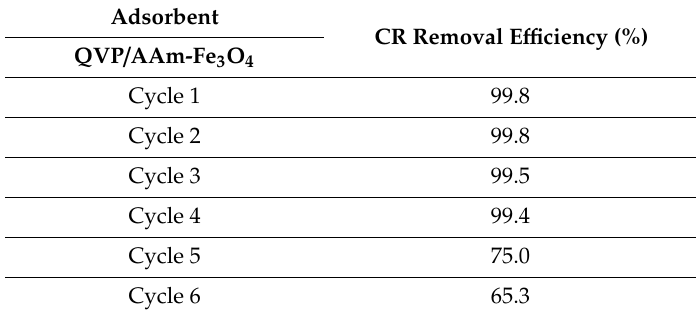
Table 5. Reusability of QVP / AAm-Fe 3 O 4 for removal of 100 mg · L − 1 dispersed in 25 mL of water at room